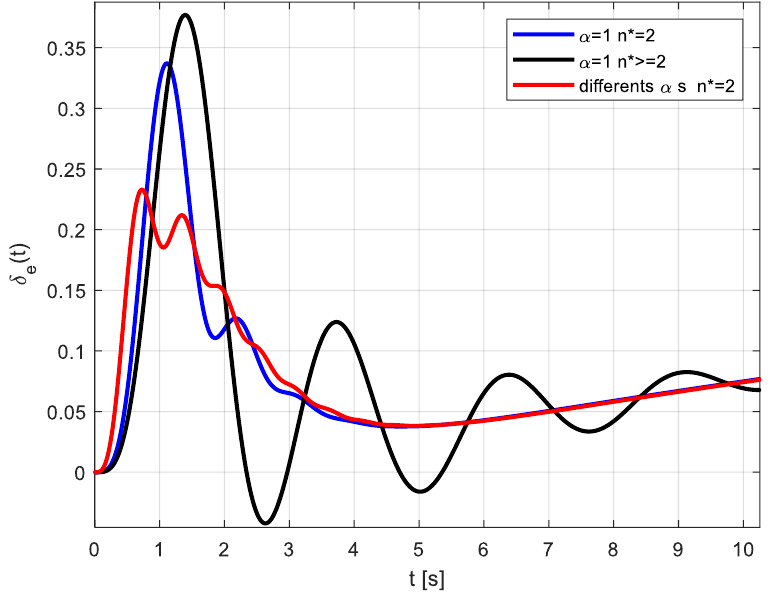
Figure 17. Zoom of the transient evolution of the control effort 𝛿 𝑒 (𝑡) during the 10 first seconds. Black signal corresponds to the generalized IO-DMRAC structure case, and IO-DMRAC (blue color) and FO-DMRAC (red color) are the cases when the simple structure is used ( 𝑛 ∗ = 2 ).